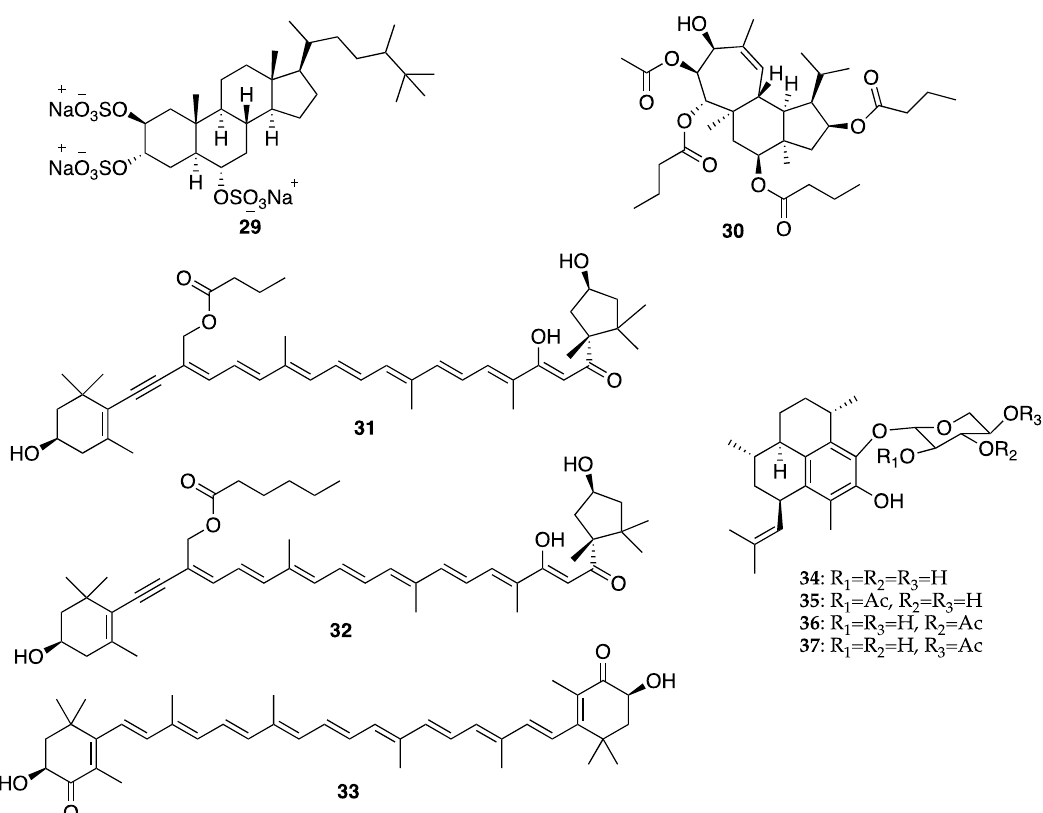
Figure 6. Structures of halistanol trisulphate ( 29 ), gagunin D ( 30 ), 19-butanoyloxymytiloxanthin ( 31 ), 19-hexanoyloxymytiloxanthin ( 32 ), astaxanthin ( 33 ), and pseudopterosins A – D ( 34-37 ).